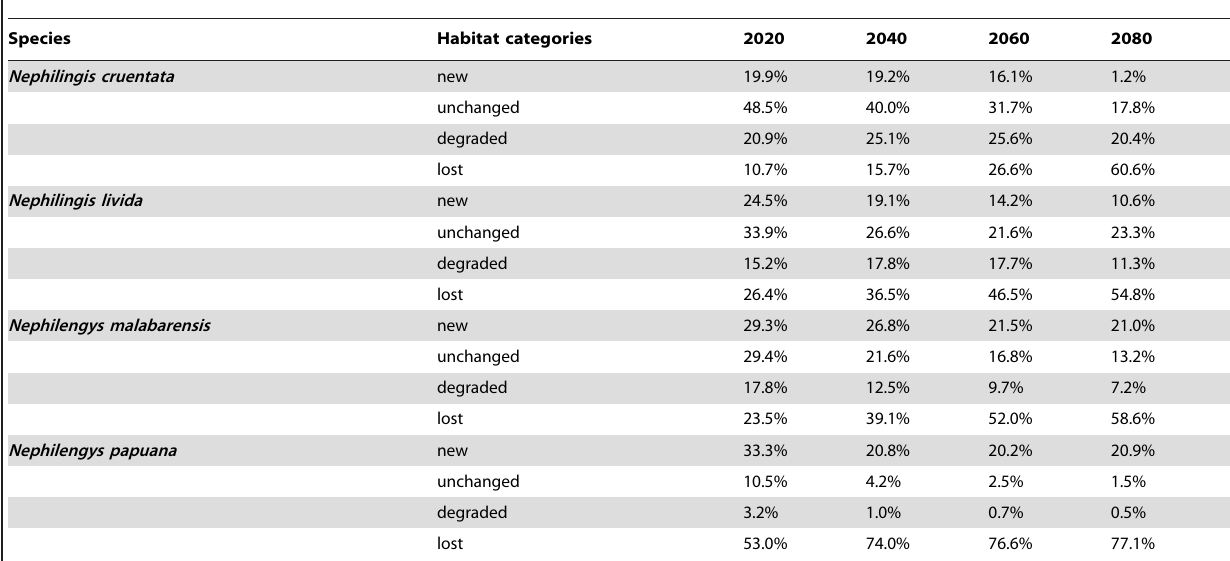
Table 1. Predicted percentages of future habitat change per species relative to the year 2000.